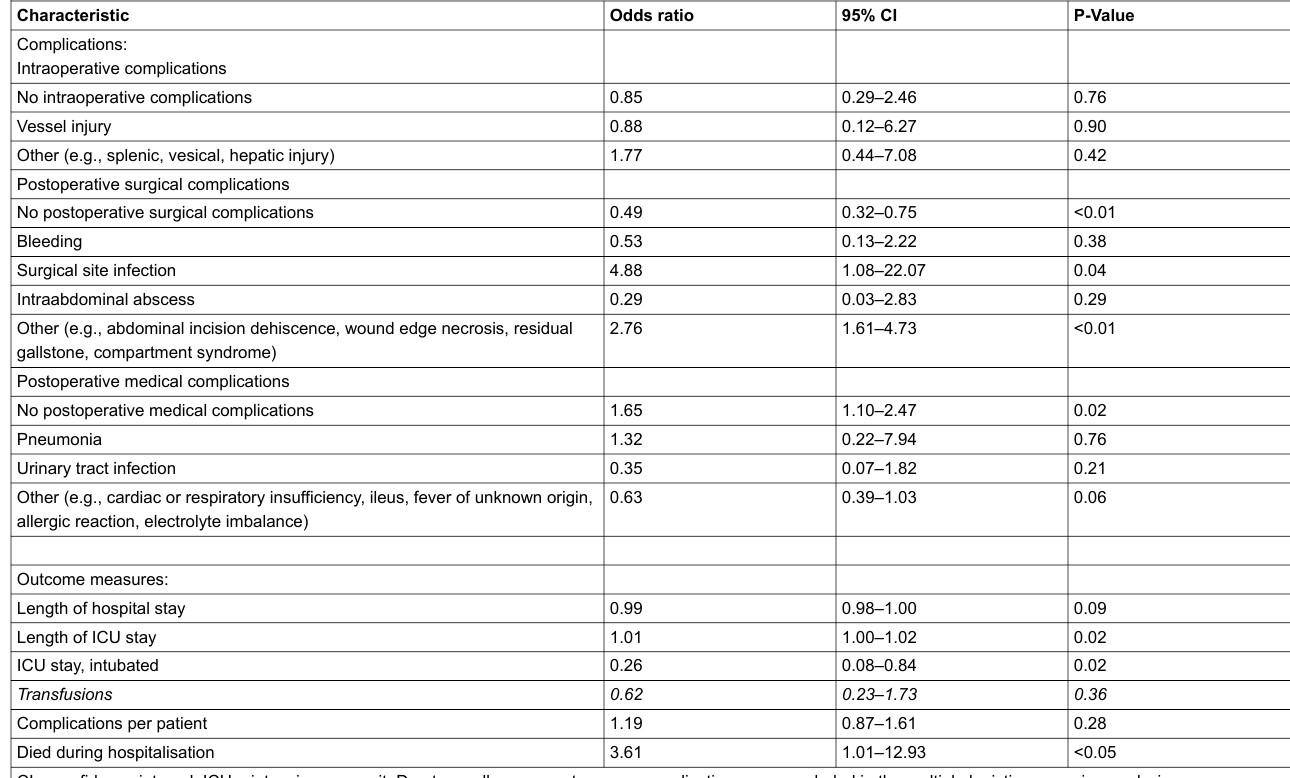
Table 3: Multivariate analysis of intraoperative, postoperative surgical and medical complications and outcome measures (n = 2,686).